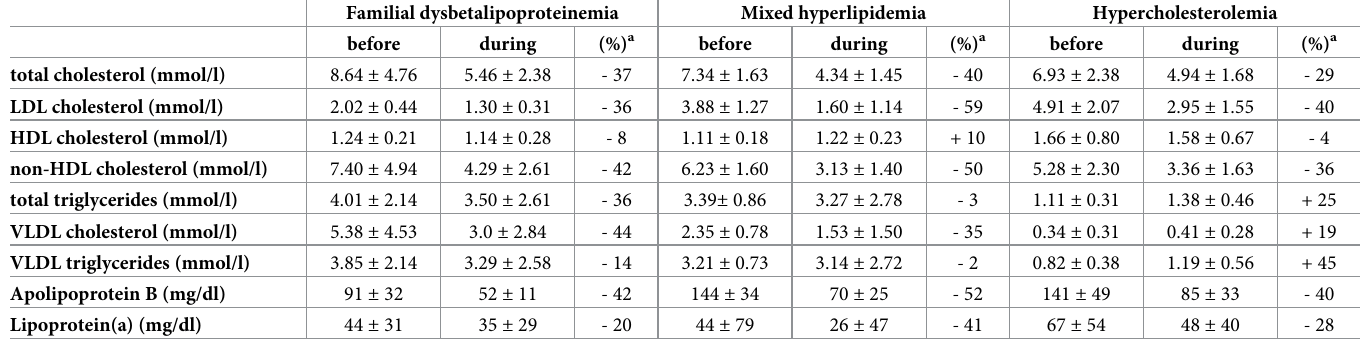
Table 2. Lipid parameters in different patient populations before and during (12 weeks) of therapy with PCSK9 inhibitors.